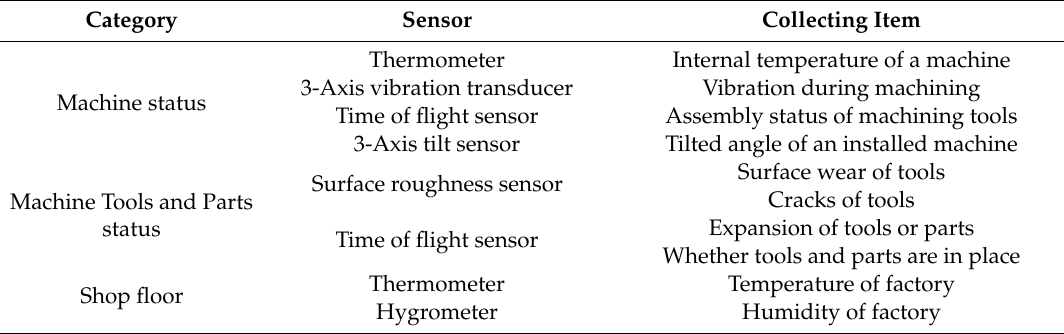
Figure 3. Structure of the data acquisition module. Table 1. Example of Internet of Things (IoT) sensors in the